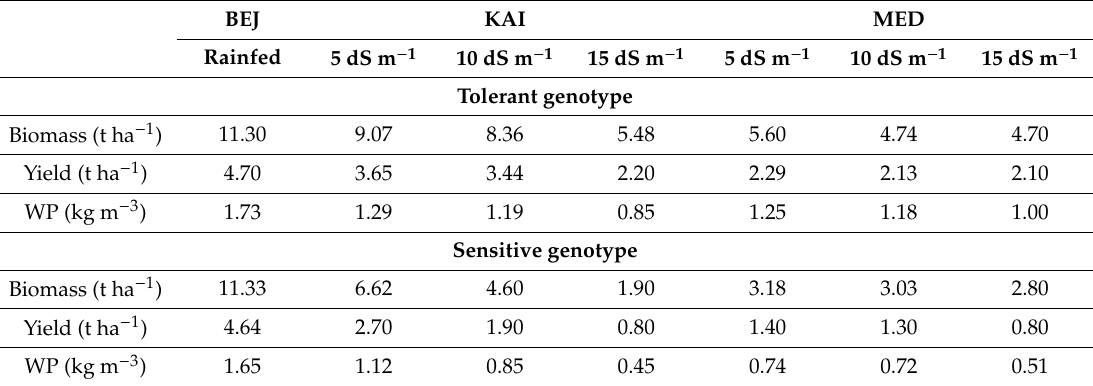
Table 6. Predicted values of biomass, yield, and water productivity of two barley varieties for di ff erent